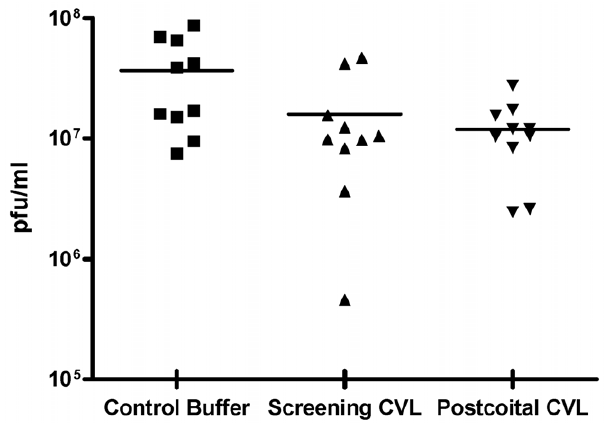
Figure 4. Endogenous anti-HSV activity in CVL collected in the absence or following coitus. CaSki cells were infected with HSV-2(G) in the presence of Visit 1 (baseline) or Visit 2 (postcoital) CVL or control buffer. Results are presented as viral titer (pfu/ml) obtained from 2 independent experiments, each conducted in duplicate.